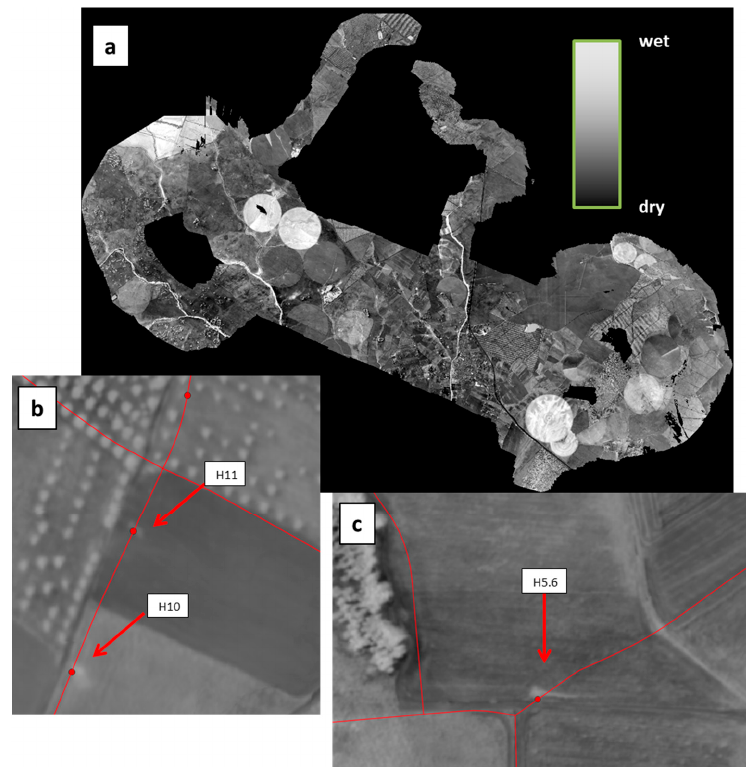
Figure 12. ( a ) WI map obtained on 16 May 2019 with the MAV over the Monte Novo district around São Manços, Portugal. The covered area is about 2 km × 10 km. ( b ) Detail of the WI image overlaid with the water network (in red) showing hydrants H10 and H11. ( c ) Same with hydrant H5.6. The three vanes were opened for periods from 10 to 60 min during the previous three days to simulate leaks.